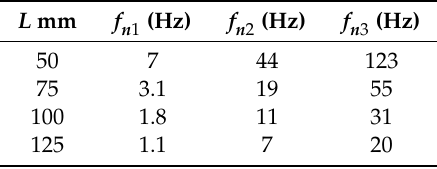
Table 6. Modal frequencies of the